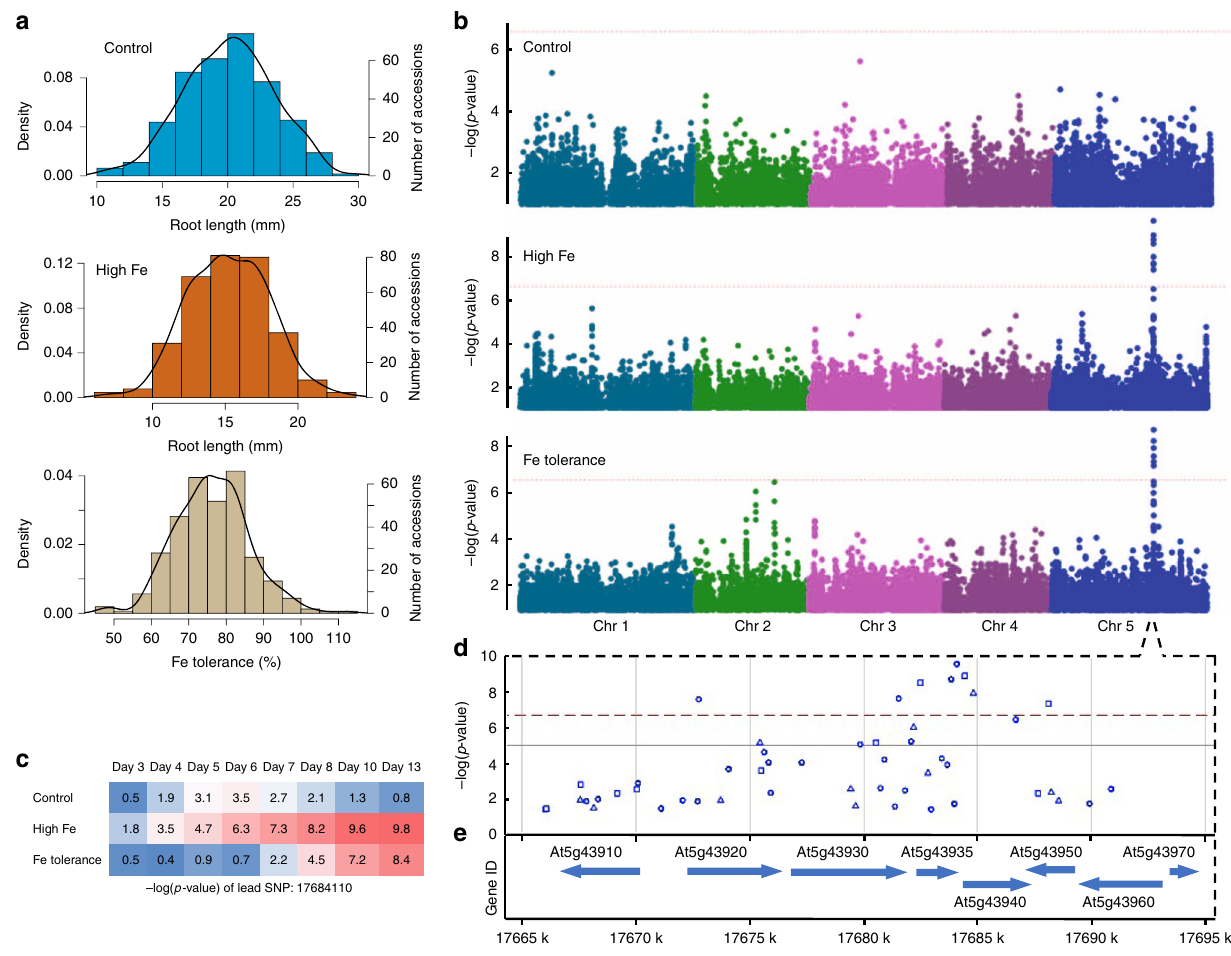
Fig. 1 GWAS identi fi es GSNOR as associated with the root growth response to high Fe. a Distributions of root length and Fe tolerance index in 319 accessions at day 10. b Manhattan plots of GWAS using traits shown in a . Different colors indicate fi ve chromosomes. The horizontal dashed lines indicated the thresholds of signi fi cance. c A heatmap of -log( p -value) of lead SNP identi fi ed at high Fe in b over the course of time. d , e Regional plots of the signi fi cant SNPs d and genes e identi fi ed at high Fe in b . GSNOR is encoded by At5g43940. Circle, triangle, and square denote the SNP to cause intergenic, non-synonymous_coding, and synonymous_coding changes, respectively. The source data of Fig. 1a are provided in a Source Data fi